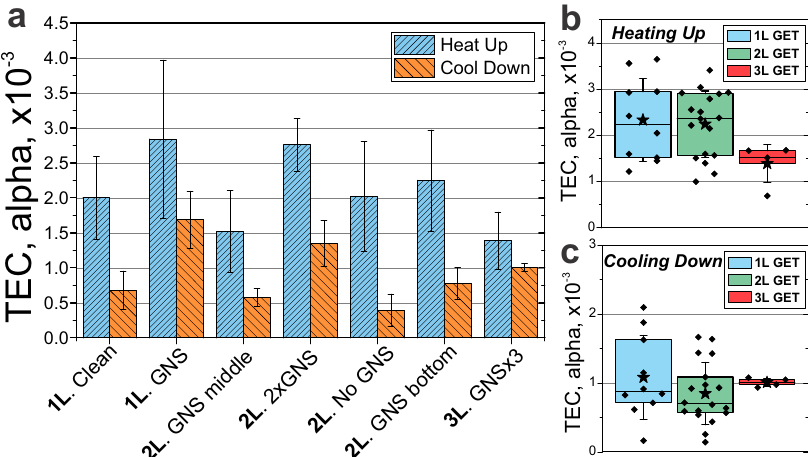
Fig. 6 Temperature sensing performance of the GETs. a average values of the TEC alpha coef fi cient for seven combinations of the 1 L, 2 L, and 3L-GETs with temperature rise up (blue) and cool down (orange). b Combined TEC alpha coef fi cients for GETs when ramping temperature upwards. c Combined TEC alpha coef fi cients for GETs when cooling GETs down. The box represents 25% and 75% with a mean, whiskers are